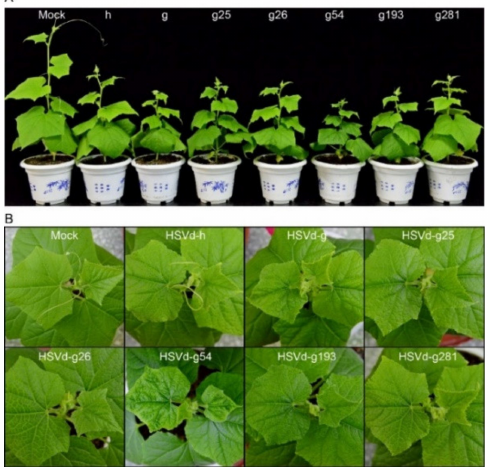
Figure 5. Symptoms on cucumber plants infected with HSVd-h, HSVd-g, or HSVd-g mutants at 28 dpi. HSVd-g mutants HSVd-g25, -g26, -g54, -g193, and -g281 were produced by site-directed mutagenesis. ( A ) E ff ect of infection on plant height. Abbreviated names of HSVd-h (h), HSVd-g (g), and HSVd-g mutants are shown above. ( B ) Symptoms on uppermost leaves of infected